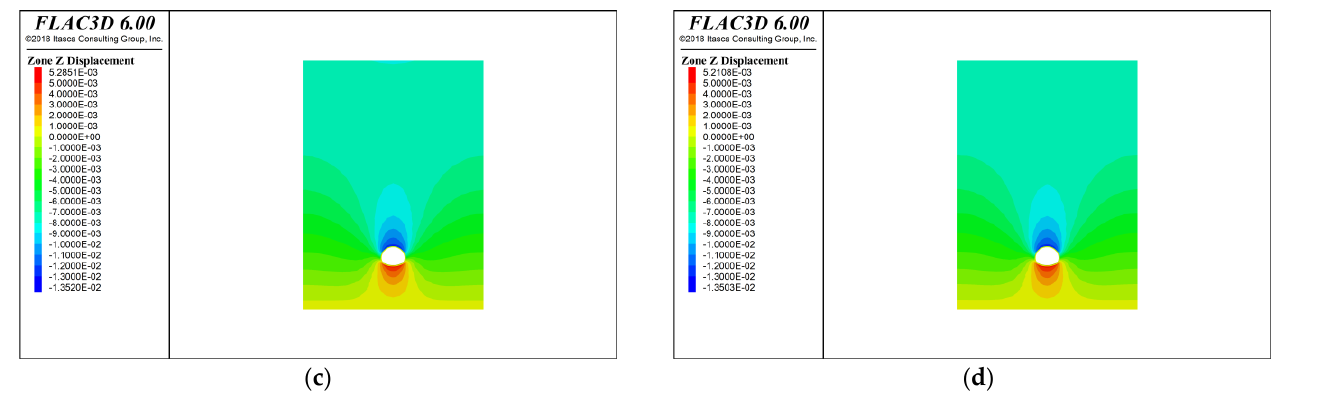
Figure 5. Model displacement nephogram. ( a ) Operation condition with grouting range of 0 m. ( b ) Operation condition with grouting range of 2 m. ( c ) Operation condition with grouting range of 4 m. ( d ) Operation condition with grouting range of 6 m.